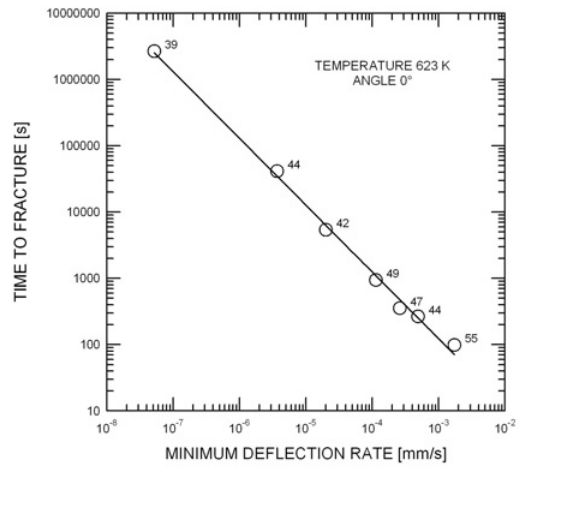
Figure 9. Dependence of time to fracture on minimum deflection rate for constant angle and different applied forces [9].